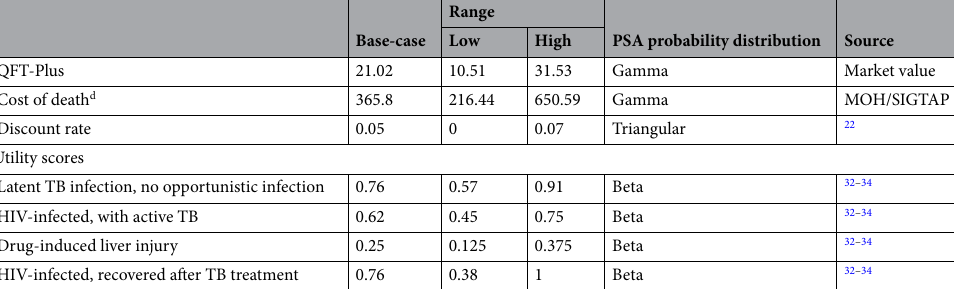
Table 1. Model parameters. TB tuberculosis; PLH people living with HIV; TST tuberculin skin test; DILI drug-induced liver injury; QFT-Plus QuantiFERON TB Gold Plus; DOT directly observed therapy; MOH Ministry of Health; SIGTAP table of procedures, medications, and orthotics, prosthetics, and special materials from the SUS; PPD purified protein derivative. a DOT costs based on of 5 weekly visits during the intensive phase (first 2 months) and twice weekly during the continuation phase (remaining 4 months). b Nursing staff time (for TST only), laboratory technician time (for QFT-Plus only). c Gloves, cotton, alcohol, syringes with needles, box for syringes, thermic box and ice bag. d Cost of death by based on hospitalization costs for pulmonary diseases.